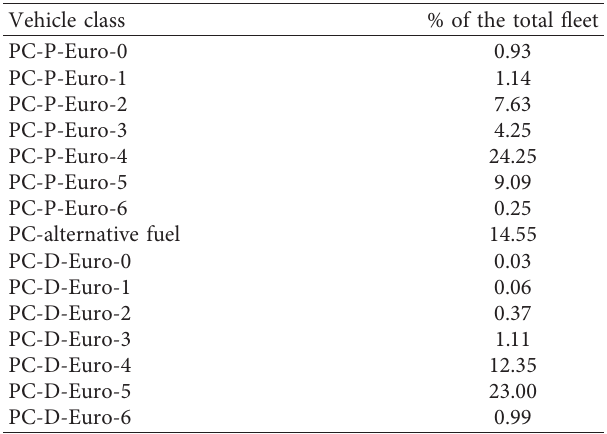
Table 2: The considered vehicle composition for passenger cars (PC) (petrol (P) and diesel (D)) according to the European standards for light-duty vehicles.